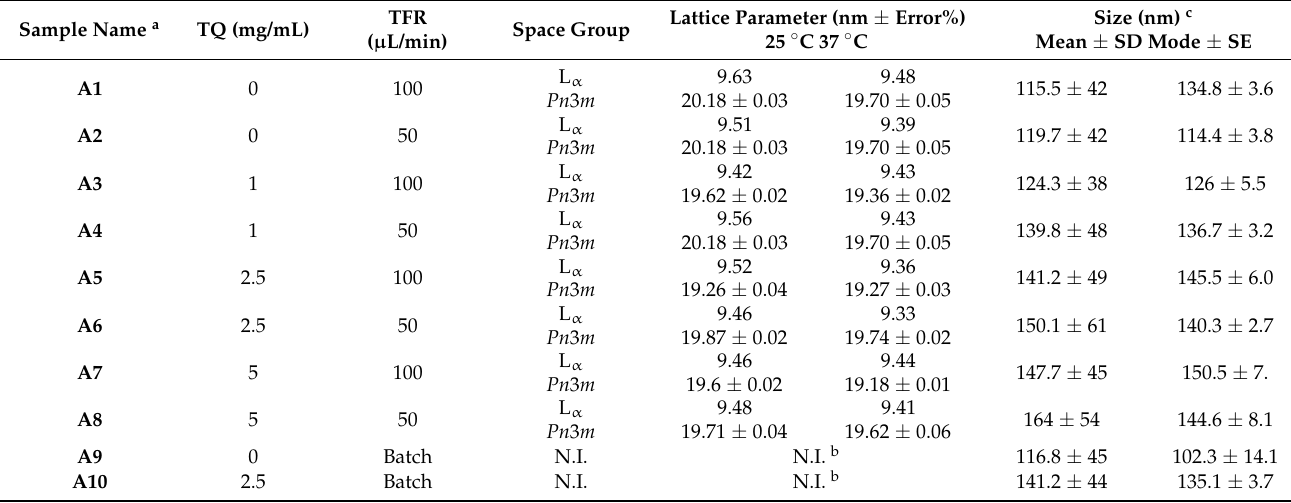
Table 1. Nanoparticle size analysis and lattice parameters of identified biphasic features of lamellar (L α ) phase in coexistence with an inverse bicontinuous cubic Pn3m phase. For determination of the structural features of the produced nano-self- assemblies, SAXS experiments were conducted at two different temperatures: 25 and 37 ◦ C; whereas NTA measurements were performed for investigating their size